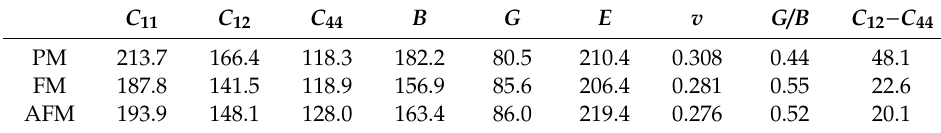
Table 1. Calculated ground state and elastic properties of PM, FM and AFM phases of (Ni,Cu) 3 (Al,Fe,Cr). Table1. CalculatedgroundstateandelasticpropertiesofPM,FMandAFMphasesof(Ni,Cu) 3 (Al,Fe,Cr).